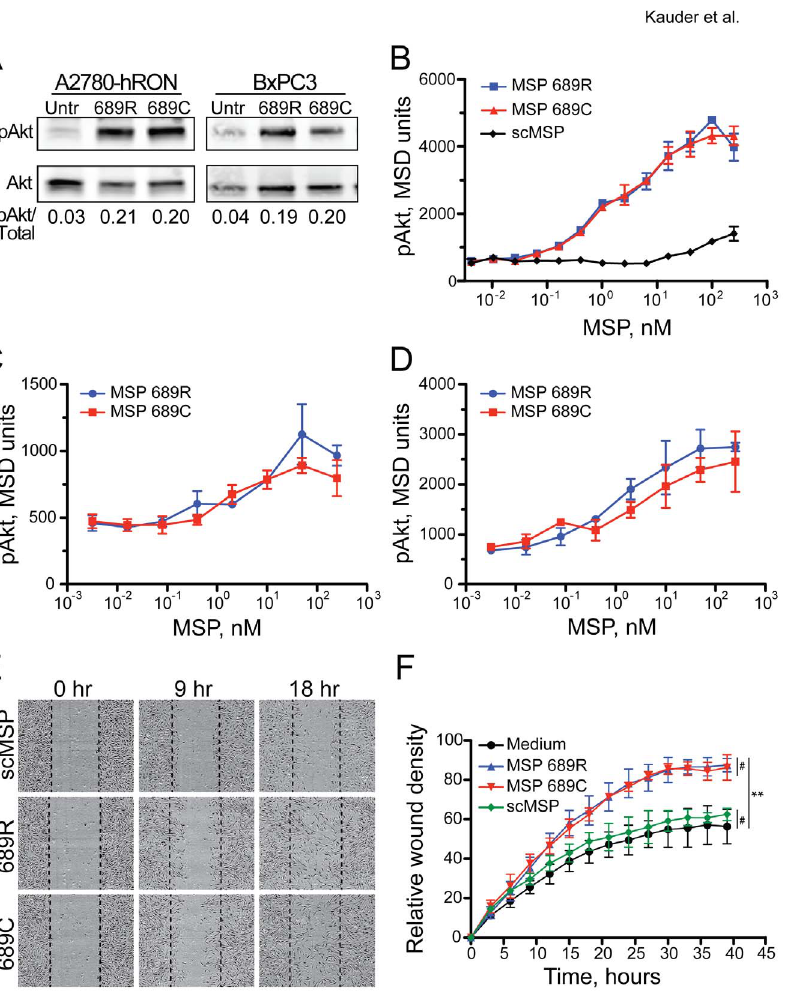
Figure 6. The 689C polymorphism does not affect MSP signaling through RON. (A) Western blot analysis of total Akt and pAkt in A2780- hRON and BxPC3 cells treated as indicated. Blot was performed in triplicate and mean of the pAkt/total ratios is shown. (B) Quantitation of pAkt by MSD analysis in 3T3-hRON cells treated with scMSP or MSP variants. Mean + / 2 SD of triplicate wells is shown. Data are representative of three independent experiments. (C) Quantification of pAkt by MSD analysis in HCT15 cells treated with MSP variants. Mean + / 2 SD of triplicate wells is shown. Data are representative of two independent experiments. (D) Quantitation of pAkt by MSD analysis in human primary colon cells treated with MSP variants. Mean + / 2 SD of triplicate wells is shown. Data are representative of two independent experiments. (E) Images from scratch wound assay of 3T3-hRON cells treated with scMSP or MSP variants. Images are from the same cell culture at the indicated times after scratch wounding. Dashed lines represent position of initial scratch. (F) Quantitation of scratch wound assay from 3T3-hRON cells treated with medium-alone, scMSP, or MSP variants. Mean + / 2 SD of three treatments is shown. Data are representative of three independent experiments. # not significant, **p # 0.0003 for comparisons between medium and MSP